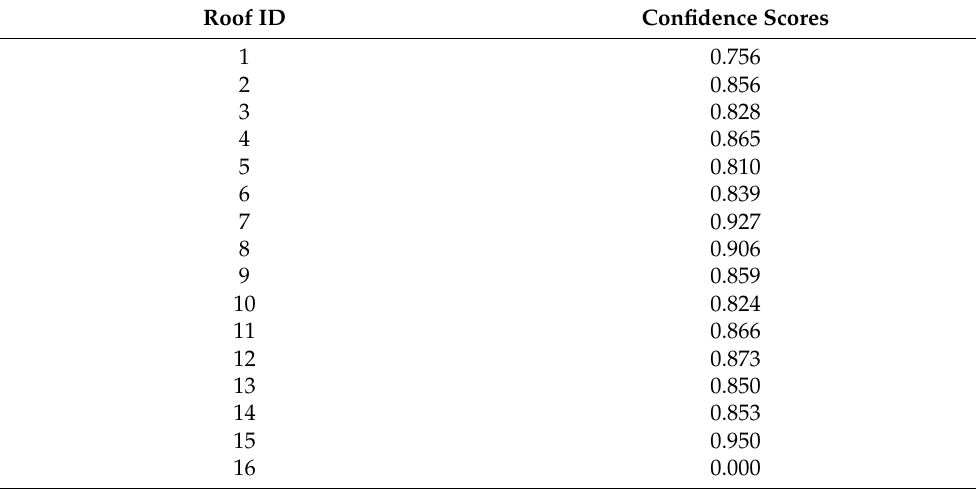
Table 1. Confidence scores for CAM building rooftops.